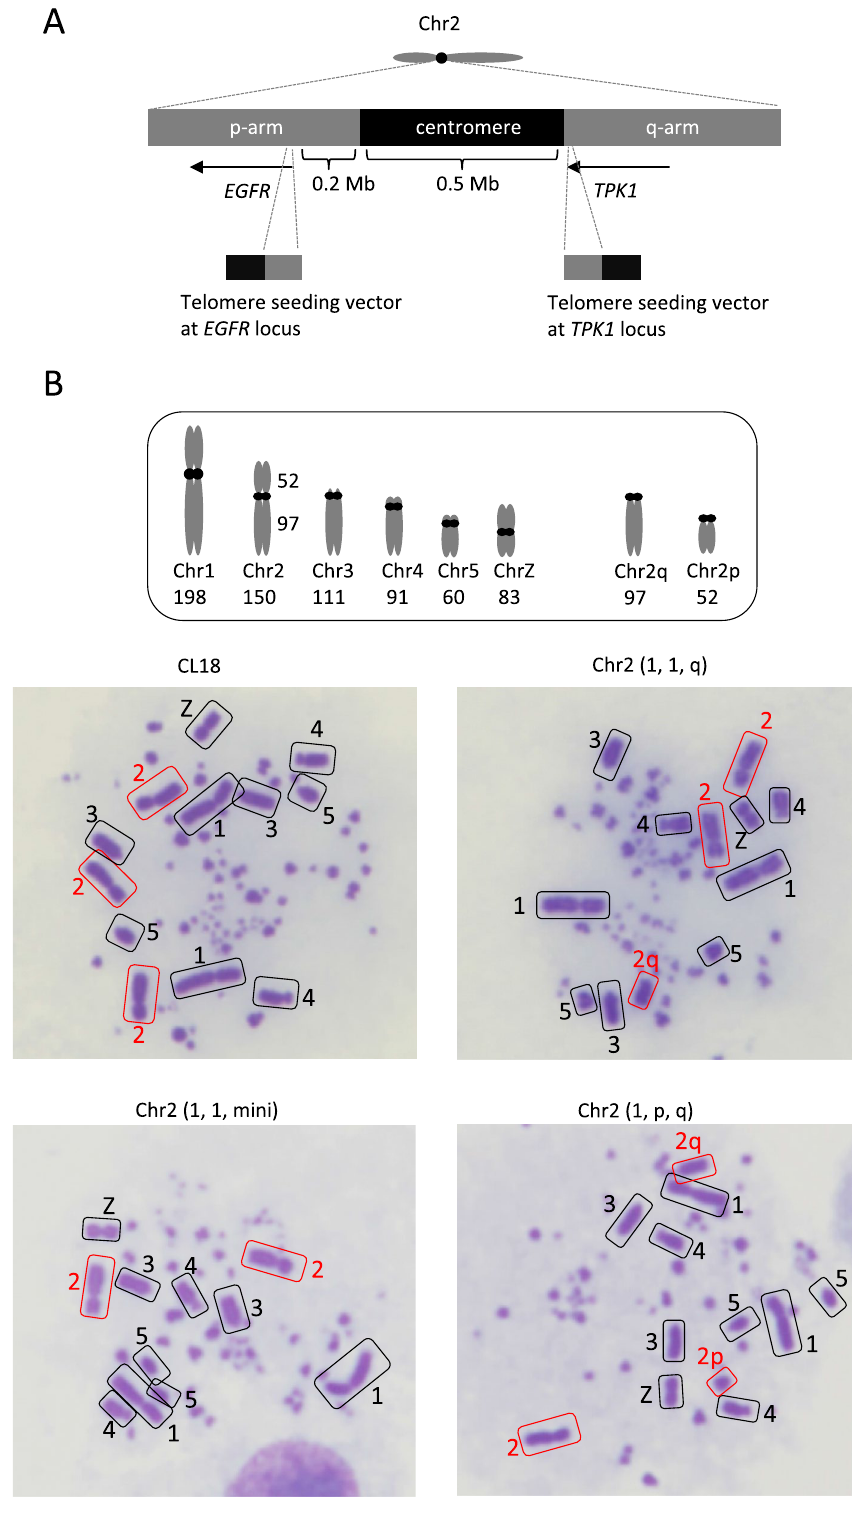
Figure 3. Establishment of mini-chromosome from a trisomic chromosome. ( A ) Schematic representation of the development of mini-chromosome from chromosome 2. Two telomere seeding vectors were designed at the end of EGFR and TPK1 loci. The exact location of telomere seeding vectors on chromosome 2 is described. ( B ) Representative images of metaphase spreads of DT40 CL18, Chr2 (1, 1, q), Chr2 (1, 1, mini) and Chr2 (1, p, q) cells. Each macro-chromosome on metaphase spreads was classified according to the shapes and length illustrated. The uniformity of karyotypes was confirmed by analyzing at least 20 metaphase